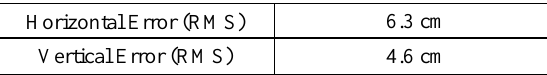
Table 2. RMS error from 142 points in a good